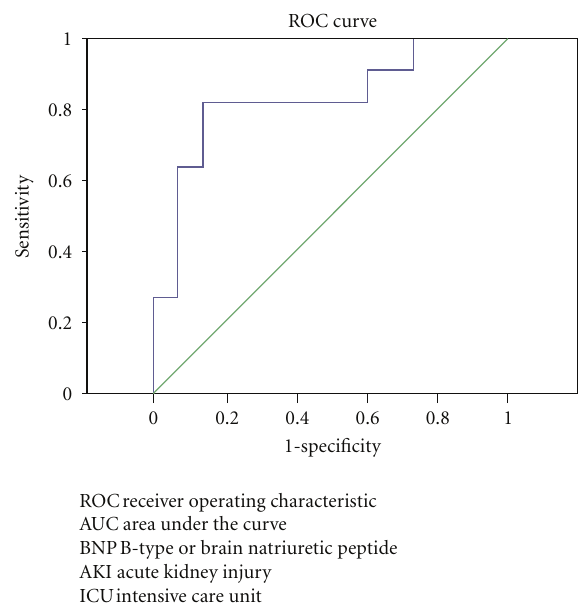
Figure 1: The ROC-AUC for BNP related to the presence of AKI on admission or development of AKI during ICU stay is